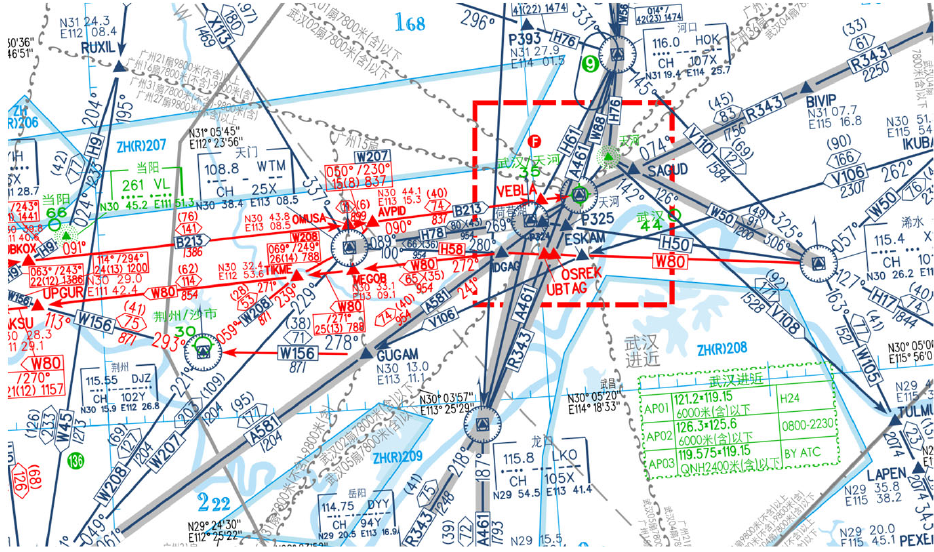
Figure 8. Part of Wuhan FIR regulated by Civil Aviation Administration of China